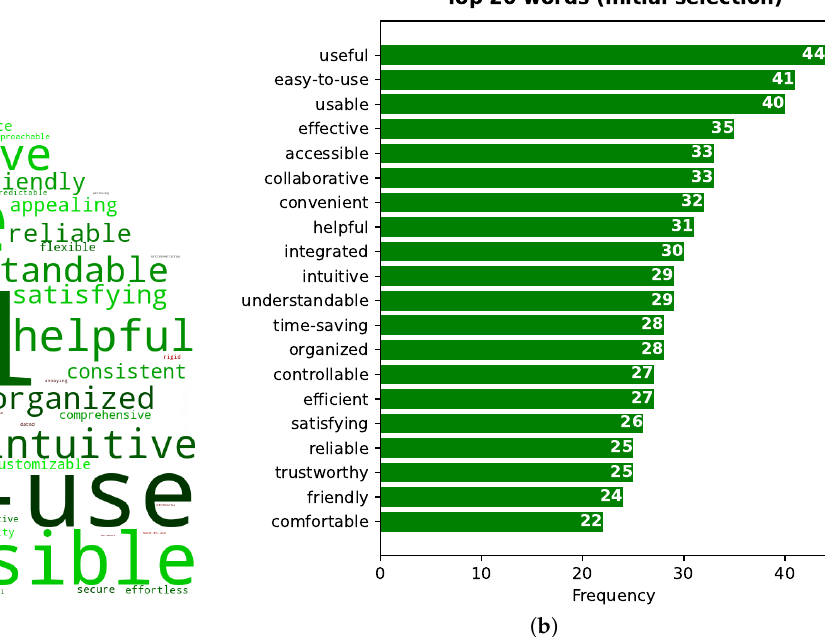
Figure 10. Word cloud considering all chosen words ( a ), and word frequency (i.e., number of times a word was chosen) considering only the twenty more frequently chosen words (top 20) ( b ), for the initial word selection of the 118-word test. In the word cloud, a larger font size means that the word was selected by more participants (higher